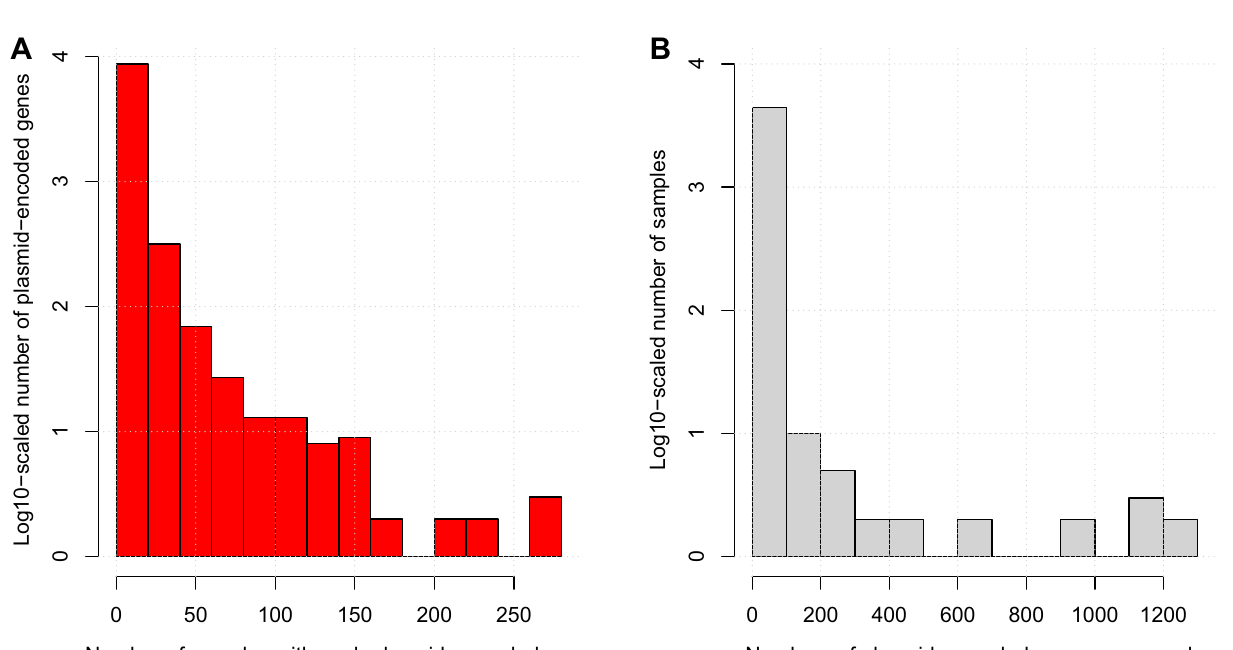
Figure 3. ( A ) The number of samples in which each plasmid-encoded gene (red) was found was generally small with a median of five. ( B ) The number of plasmid-encoded genes per sample (grey) had a median of three, including six E. coli samples with a median of 1035 plasmid-encoded genes per sample that represent all samples with > 400 genes. These figures excluded samples with no plasmid-encoded (n = 57, Z = 0.77) was the most variable order, with limited changes at the class and order levels. Overall, the plasmid-encoded gene profiles per taxonomic group did not yield an informative taxonomic resolution (Fig- ure S3, see full figure FigShare https:// doi. org/ 10. 6084/ m9. figsh are. 19525 435). Evidence for this low overall covariation came from PCA of this data where six E. coli and three Ralstonia solanacearum samples explained most variation across PC1 (34.5%) and PC2 (5.6%) (Figure S4A). These six E. coli had far more plasmid-encoded genes compared to the sample with the next highest number ( Ralstonia solanacearum PSI07 with 347), which in turn exceeded the other samples substantially. Excluding these nine